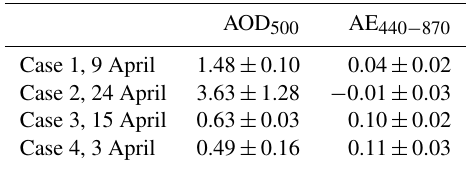
Table 1. Daily averaged AOD at 500nm and Ångström exponent (AE; between 440 and 870nm) measured by the sun–sky photome- ter in daytime. The values on the right side of “ ± ” represent the standard deviation of the values on the left